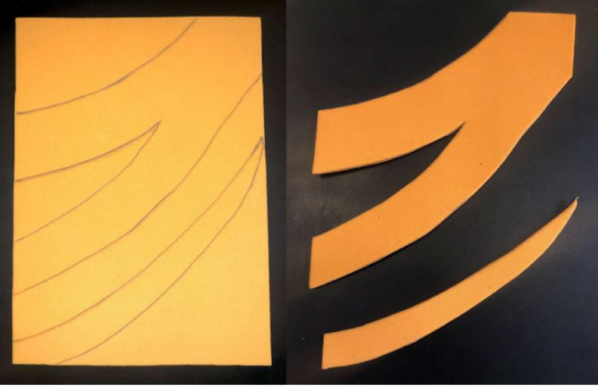
Figure 3. Costal cartilage in plastic